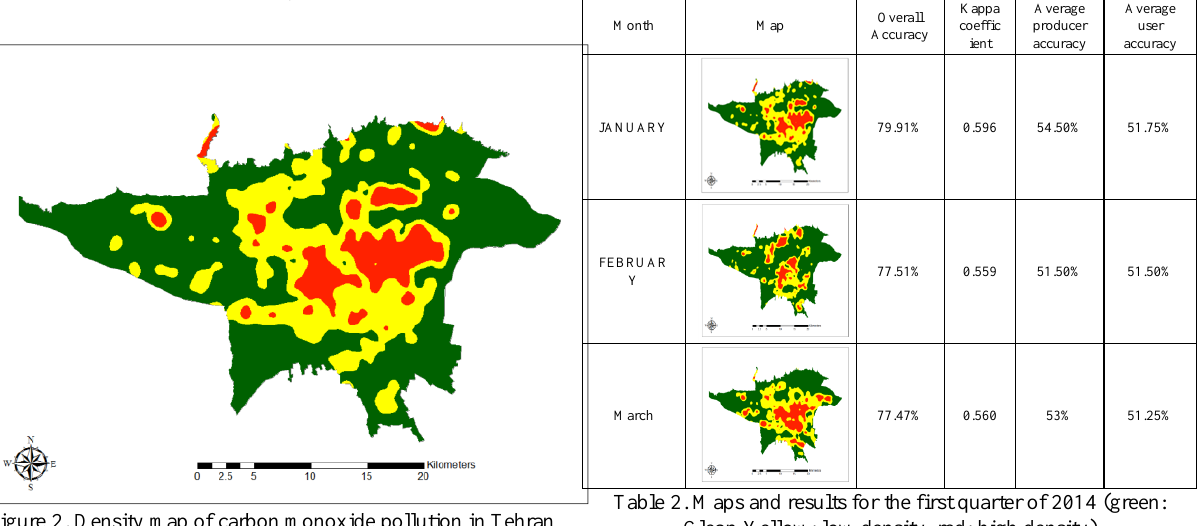
Figure 1. Reflects the whole curve of carbon monoxide (Rueger, 1996).